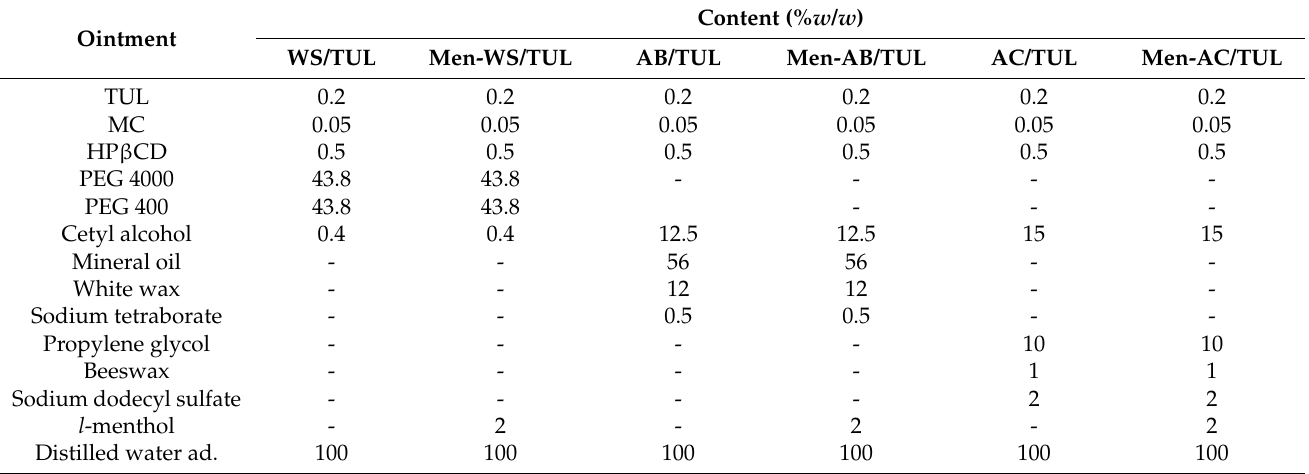
Table 1. Compositions of WS/TUL, AB/TUL, and AC/TUL ointments with and without l